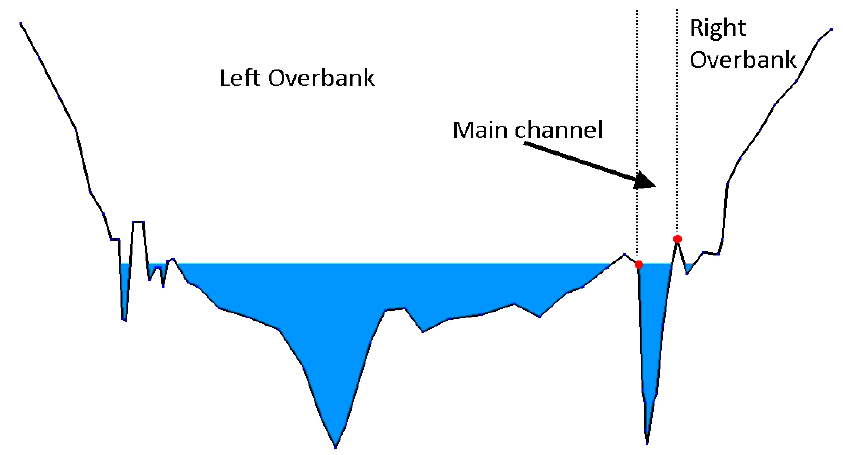
Figure 1 . Natural section with three regions, main channel, left and right overbanks Figure 1. Natural section with three regions, main channel, left and right